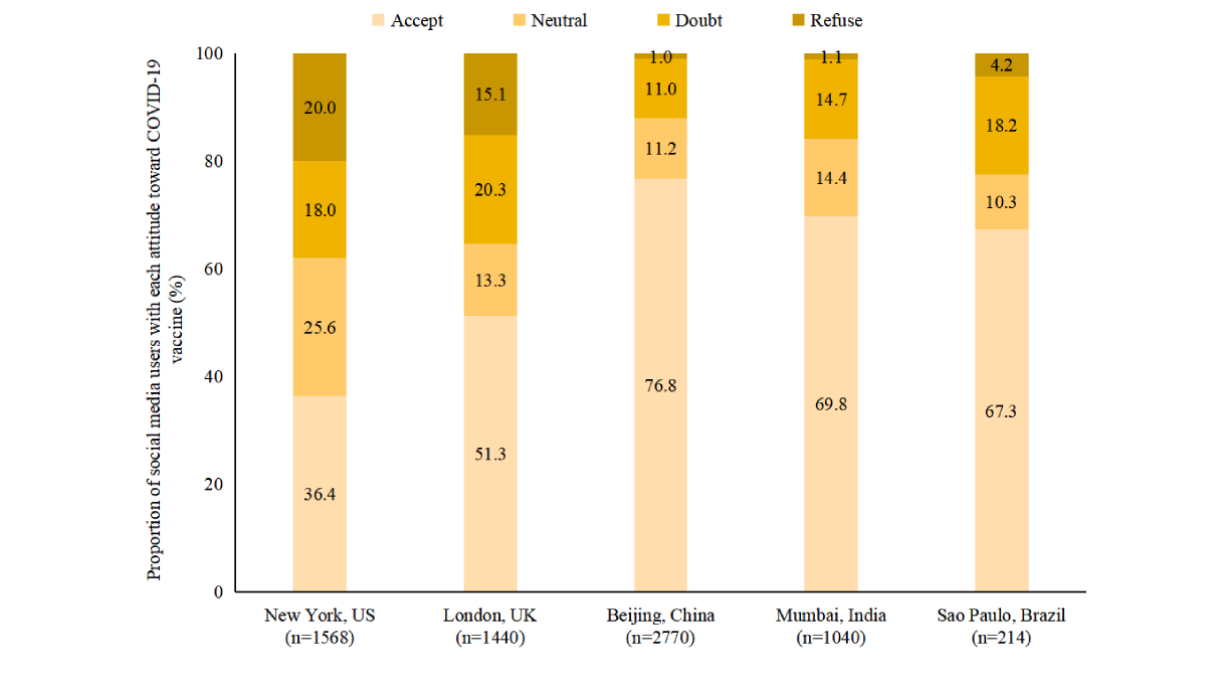
Figure 3. Expectations of COVID-19 vaccine R&D and introduction. R&D: research and development.